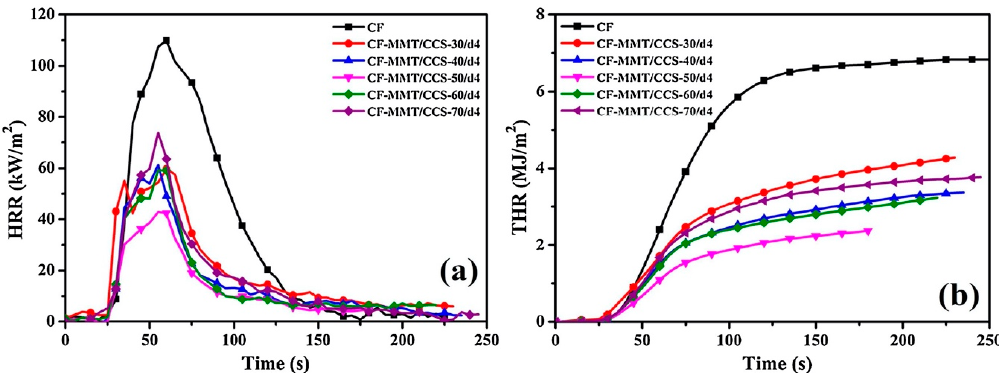
Figure 22. Heat Release Rate ( a ) and Total Heat Release ( b ) curves vs. time for untreated cotton (CF) and for the fabric treated with di ff erent modified montmorillonite / carboxymethyl chitosan dip-coating baths. CF-MMT / CCS- X / d n : X represents the weight percent of modified montmorillonite (MMT) in the montmorillonite / carboxymethyl chitosan (CCS) dispersion, while n corresponds to the repetition times of the dip-coating process. Reprinted with permission from [51]. Copyright 2019, Elsevier.